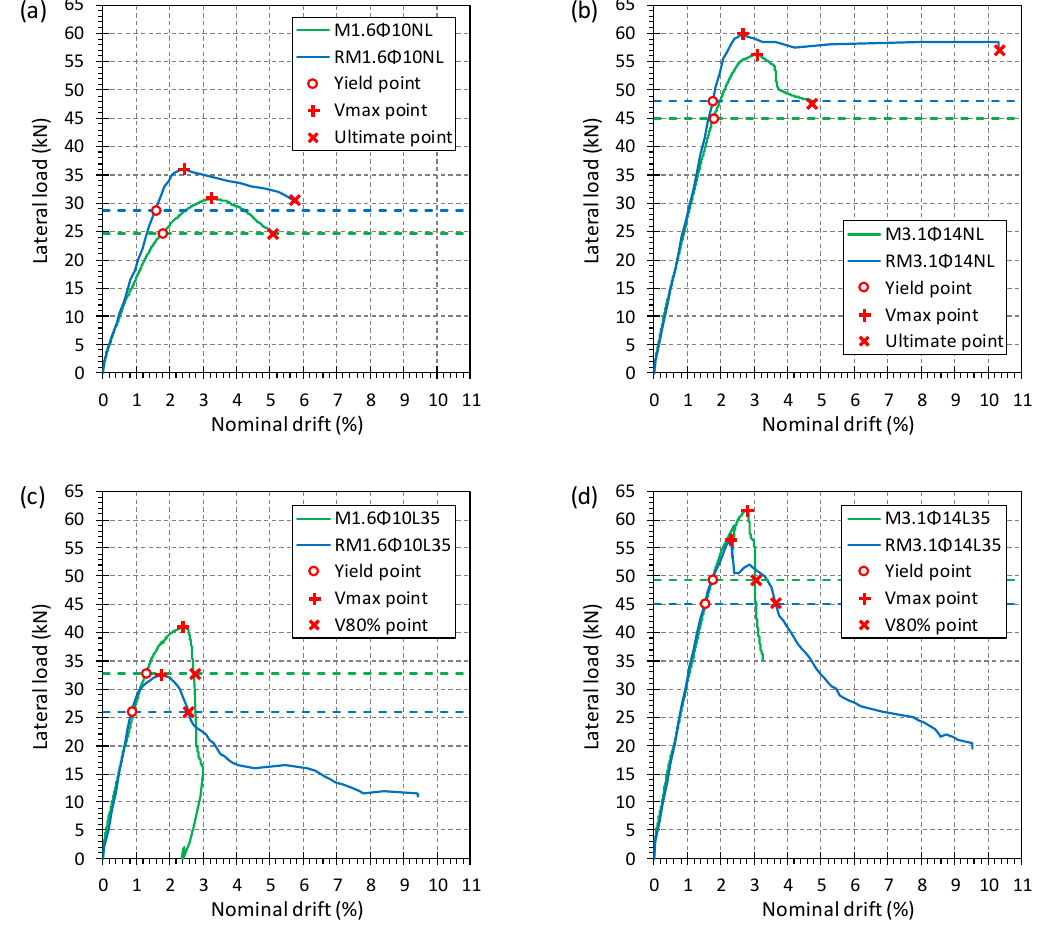
Figure 12. Envelope curves of specimens: ( a ) M1.6 Φ 10 Ν L vs. RM1.6 Φ 10 Ν L; ( b ) M3.1 Φ 14 Ν L vs. RM3.1 Φ 14 Ν L; ( c ) M1.6 Φ 10L35 vs. RM1.6 Φ 10L35; ( d ) M3.1 Φ 14L35 vs. RM3.1 Φ 14L35.